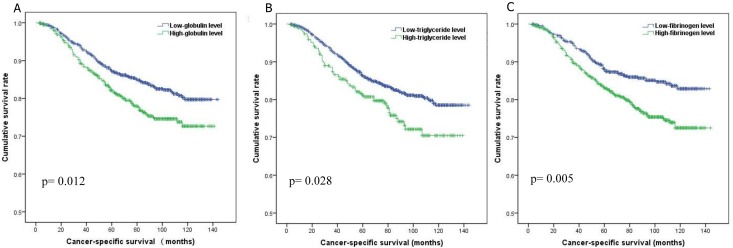
Cancer-specific survival of patients according to globulin level (A), triglyceride level (B) and fibrinogen level (C).